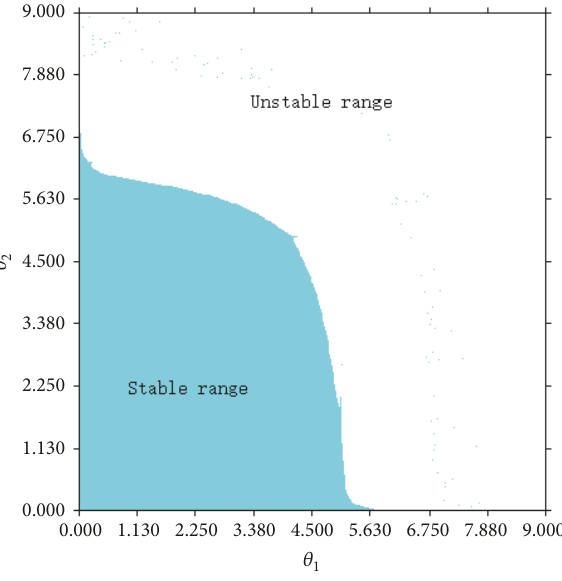
Figure 11: The stable range of system (20).